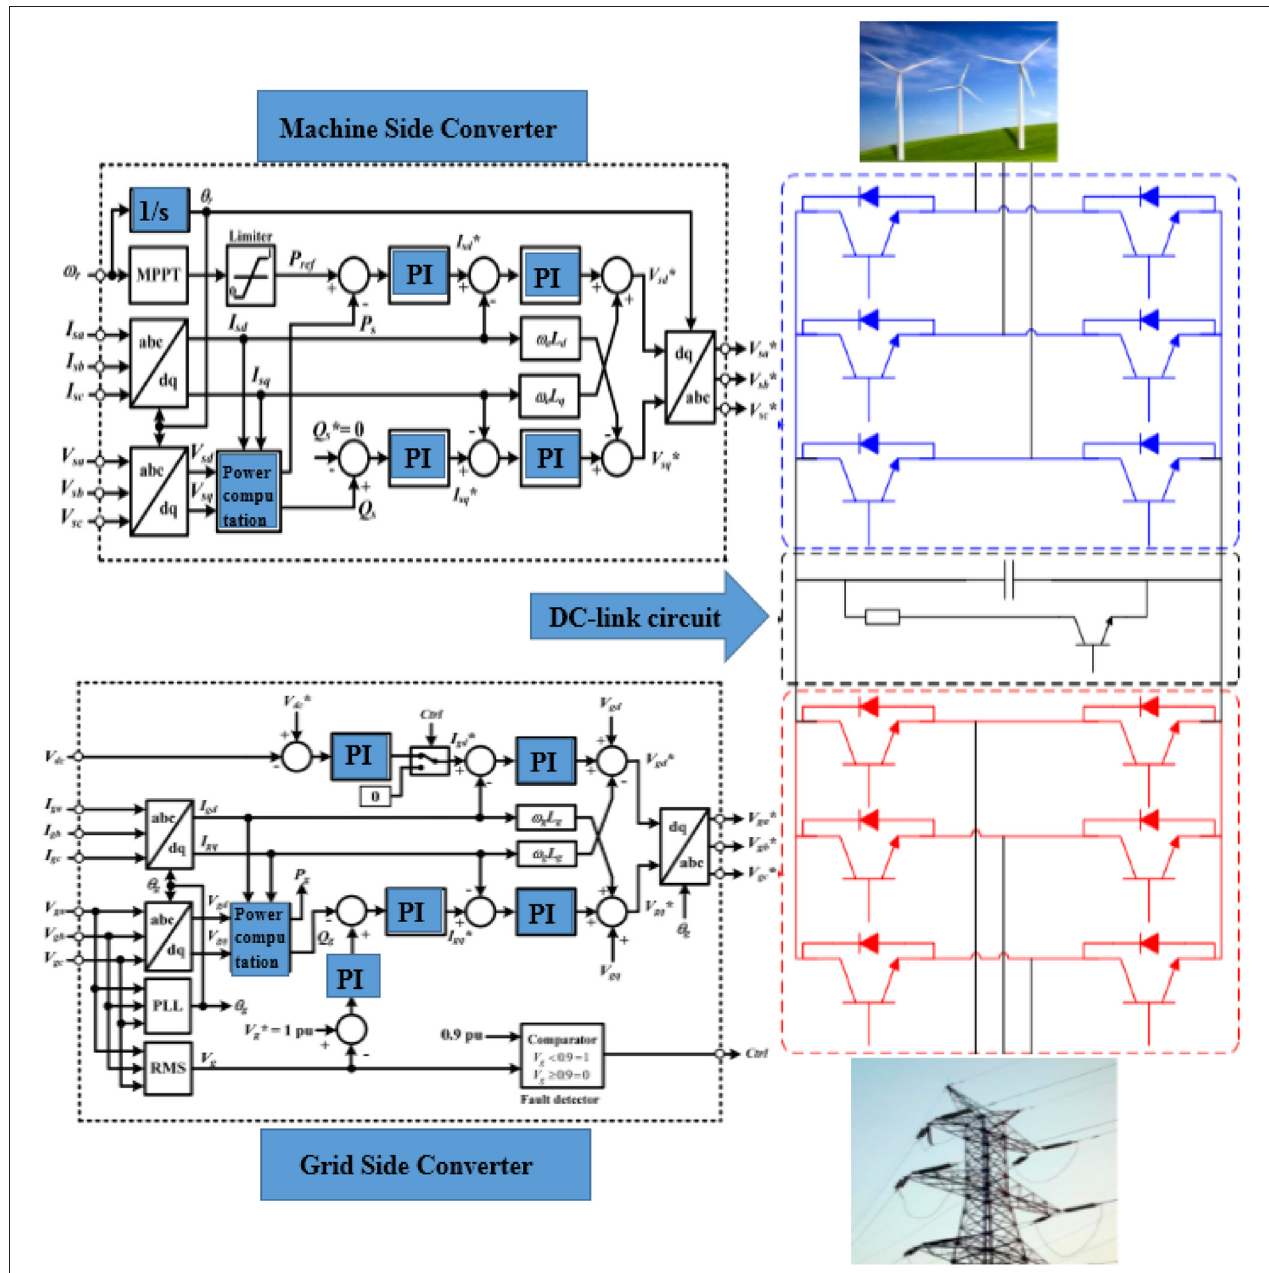
FIGURE 6 | Control strategy of the PMSG wind turbine.